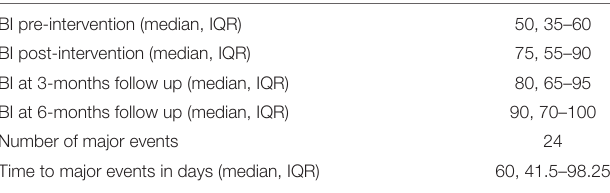
TABLE 3 | Functional outcome parameters (BI, Barthel Index; IQR, interquartile